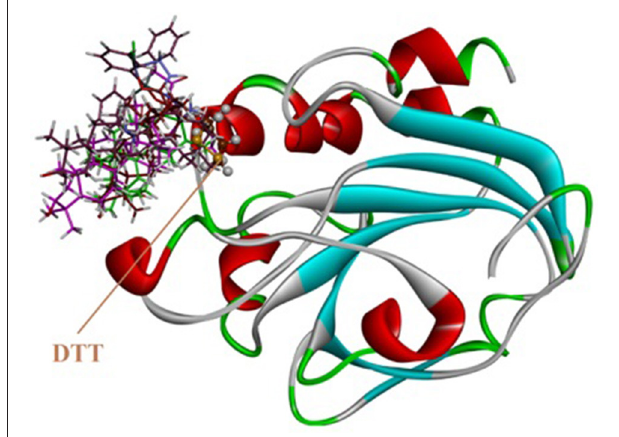
FIGURE 9 | Superposed 3D modeled diagram of some metal complexes into the active site of 3MNG.